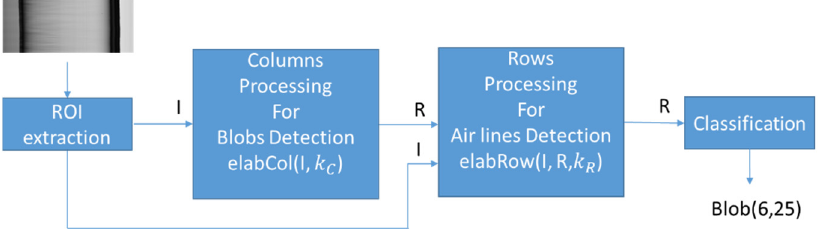
Figure 9. Variation of luminous intensity for pixels that belong to the same row with an air line defect inside the ROI. Values of negative peaks below (or positive peaks over) a given threshold may represent the air line defects.